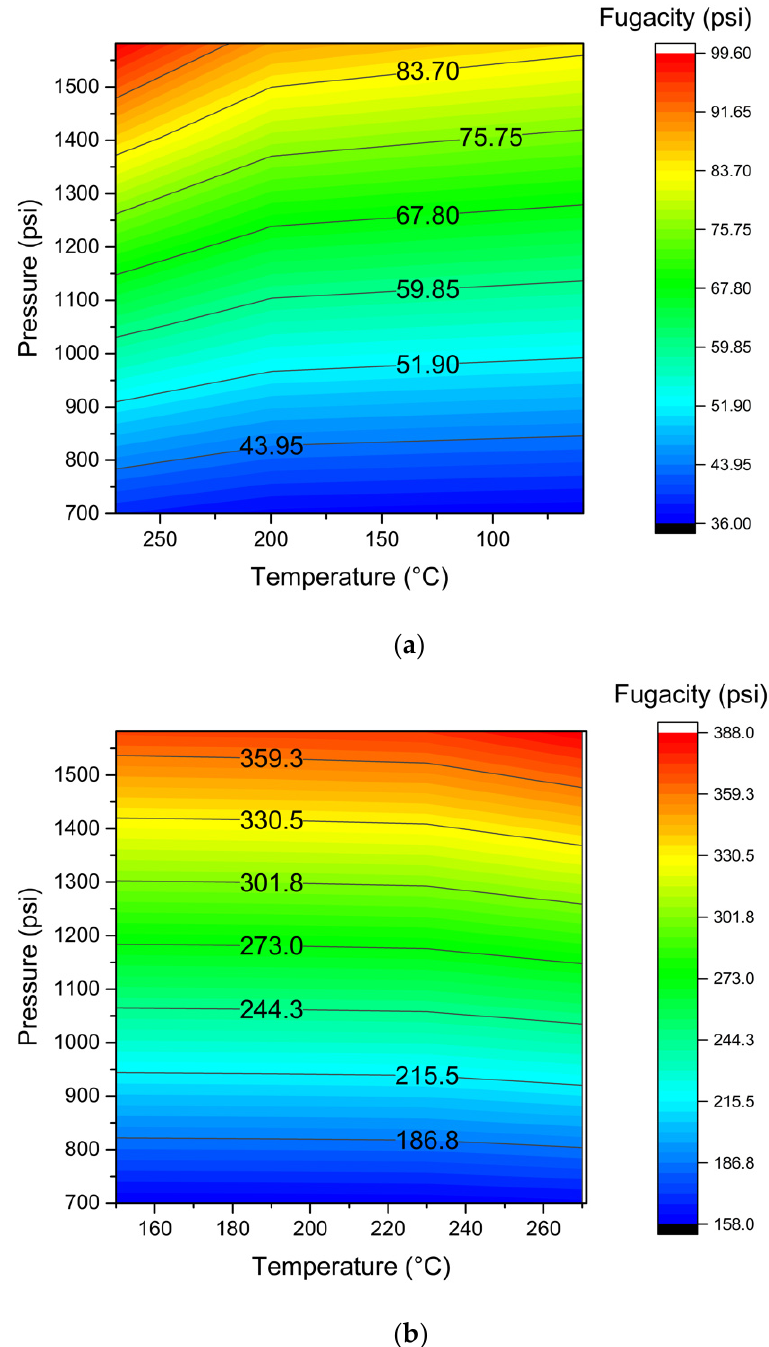
Figure 6. Fugacity contour of H 2 generated during the steam injection in the ( a ) absence and ( b ) presence of nanoparticles on HO1 between reservoir pressure (700 psi) and overburden pressure (1600 psi) as a function of temperature decline.